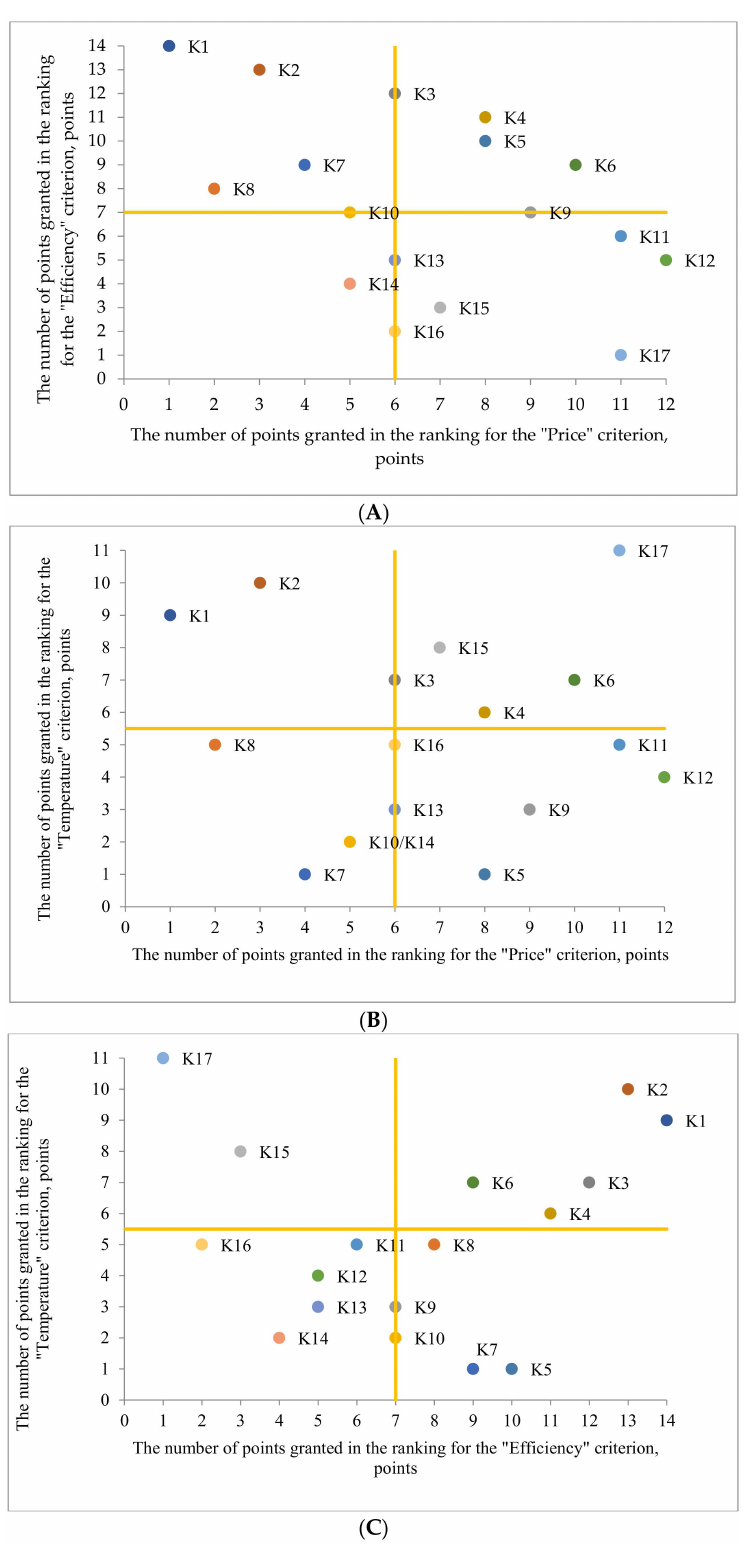
Figure 1. ( A ) Competitive position matrix of selected PV panel technologies against “Price/Efficiency”. ( B ) Competitive position matrix of selected PV panel technologies against “Price/Temperature”. ( C ) Competitive position matrix of selected PV panel technologies against Temperature/Efficiency. When analyzing the PT (“Price/Temperature”) matrix, the more temperature tolerant technologies have a price above average (upper left part of the matrix) (Figure 1B).